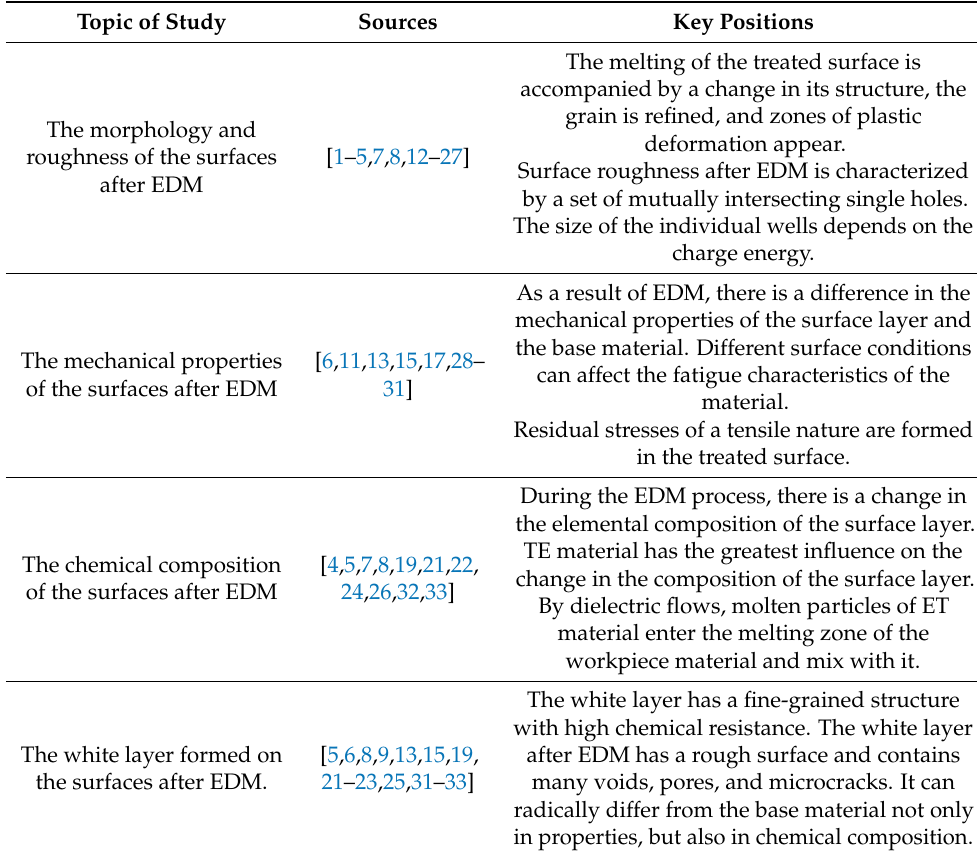
Table 1. The main directions of research of the process of